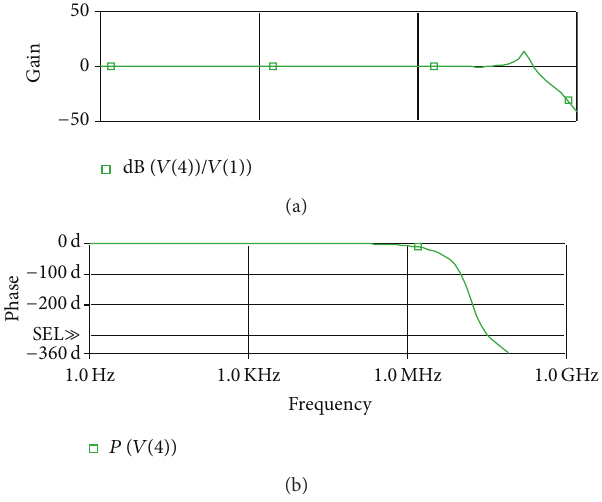
Figure 6: Gain (dB) and phase (deg) response of second-order voltage-mode all-pass filter of Figure